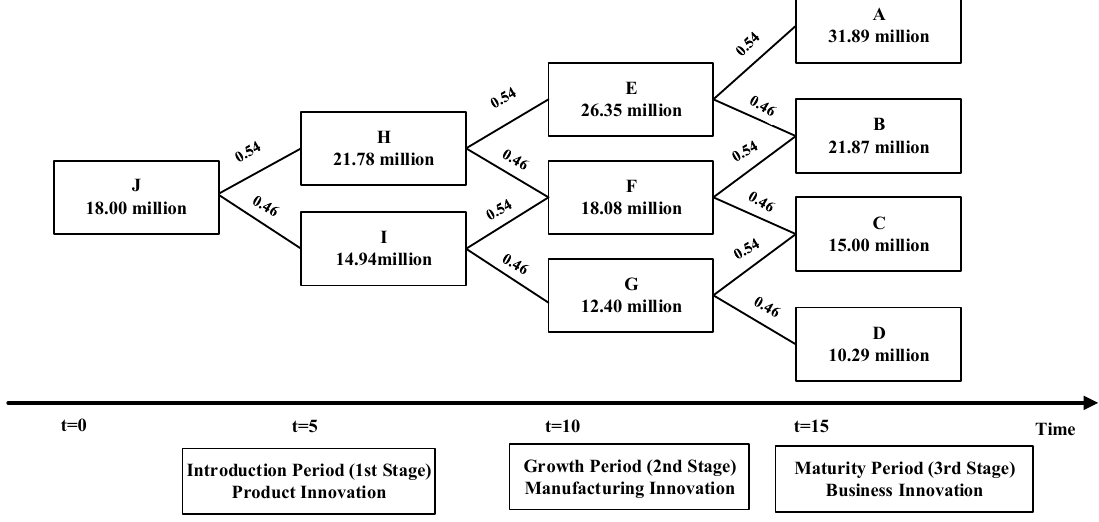
Figure 4. Revenue ( SR i ) changes path ( r = 0.68% ).